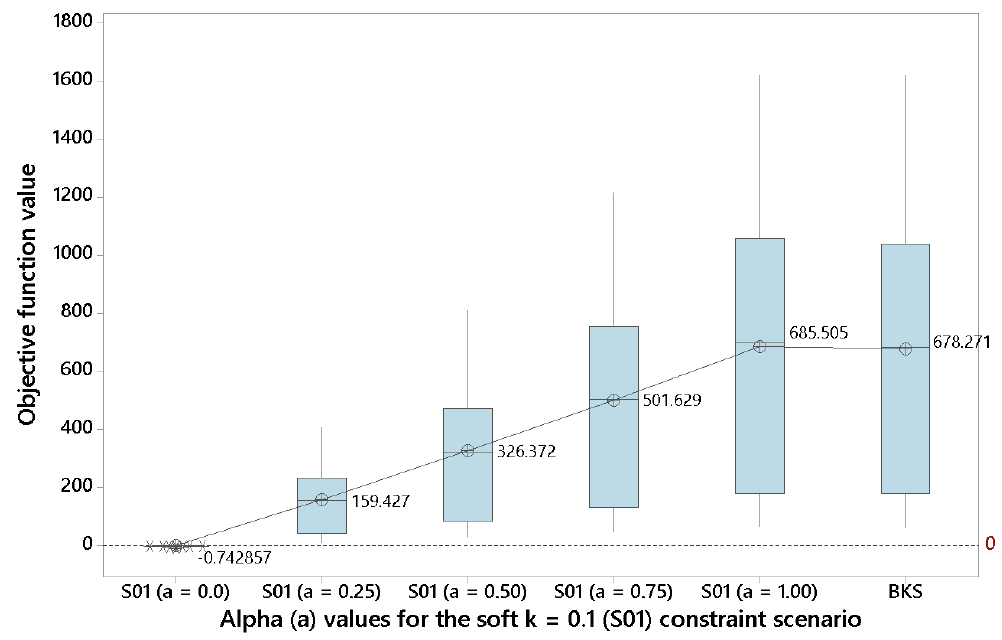
Figure 4. Results for different alpha values under the soft constraint scenario with k = 0.1 (source: own elaboration).